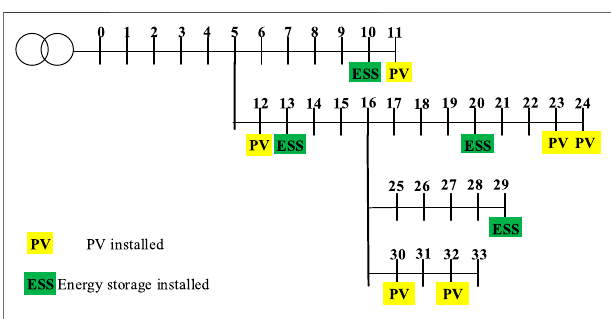
FIGURE 2 | Topology of 10 kV feeder under